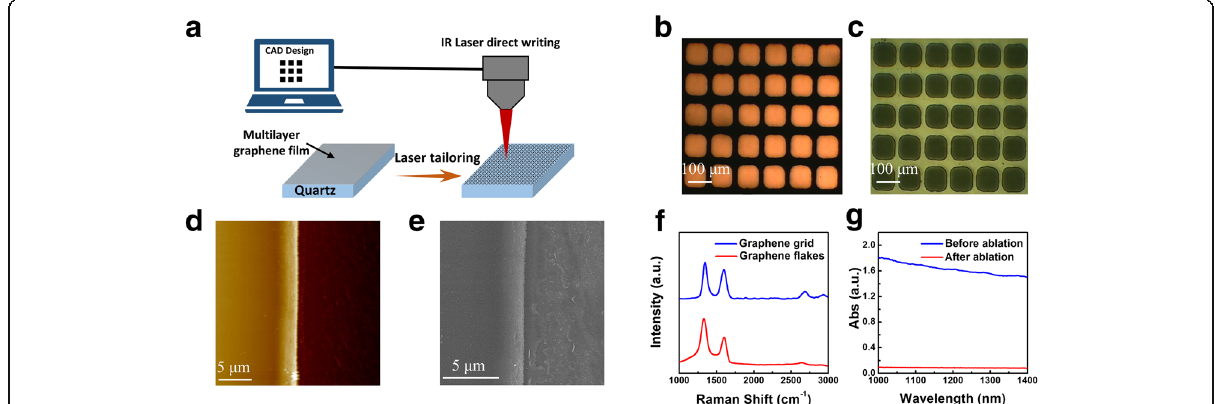
Fig. 2 Laser tailoring of MGF and fabrication of MGFG. a Schematic illustration of graphene grid ablation process by IR laser direct writing. b , c Microscope images of the fabricated MGFG at transmission mode and reflection mode, respectively. d , e AFM and SEM images of tailored edge. f Raman spectrum of graphene grid and flakes in the ablation area ( at 633 nm excitation wavelength). g IR absorption of MGF before and after